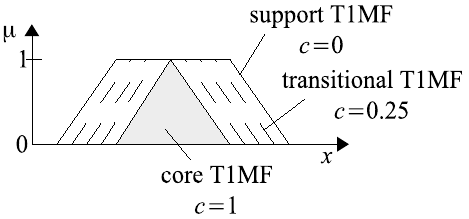
Figure 11. Example FOU of a T2FS with transitional T1MFs with assigned fractional confidence degrees c ∈ [ 0,1 ] .